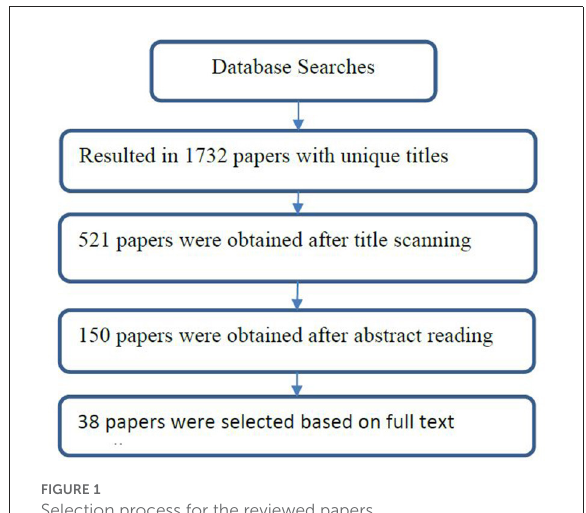
FIGURE1 Selection process for the reviewed